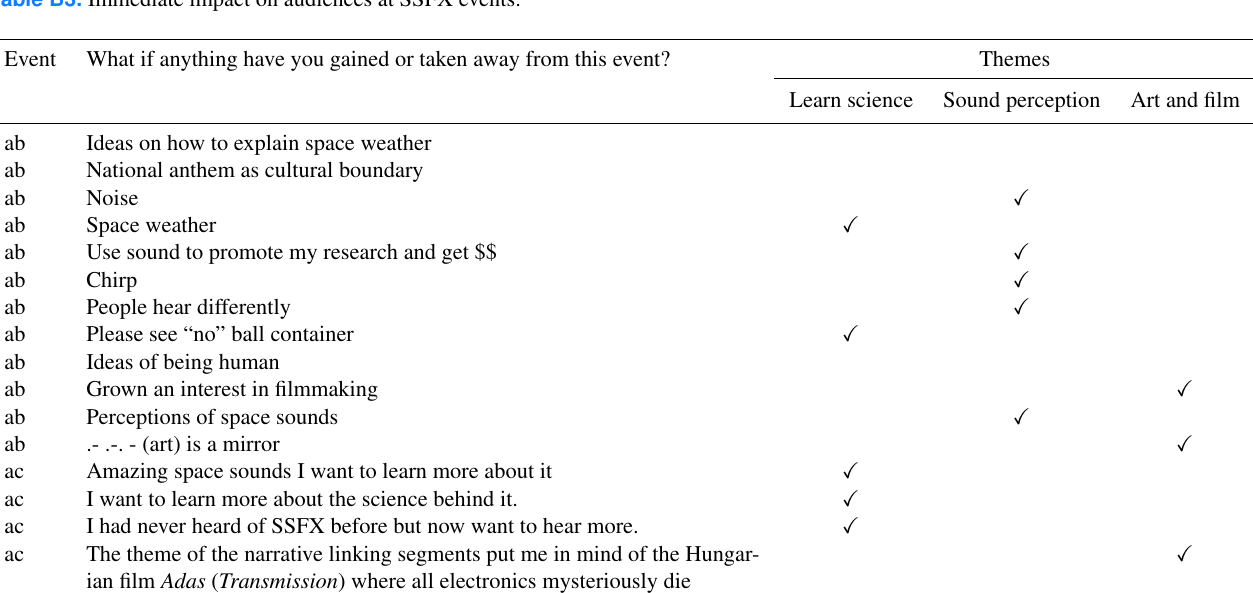
Table B3. Immediate impact on audiences at SSFX events.